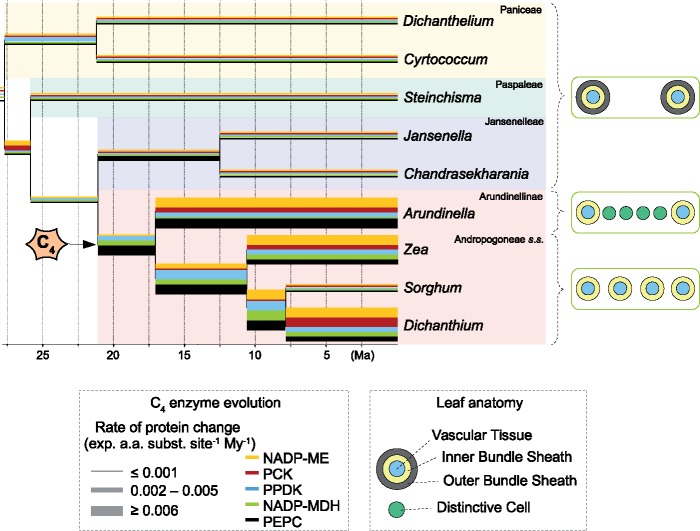
C\documentclass[12pt]{minimal}
\usepackage{amsmath}
\usepackage{wasysym}
\usepackage{amsfonts}
\usepackage{amssymb}
\usepackage{amsbsy}
\usepackage{upgreek}
\usepackage{mathrsfs}
\setlength{\oddsidemargin}{-69pt}
\begin{document}
}{}$_{4}$\end{document}-related changes in protein sequences and leaf anatomy in the Andropogoneae grasses. A time-calibrated phylogenetic tree of Panicoideae is presented, with selected C\documentclass[12pt]{minimal}
\usepackage{amsmath}
\usepackage{wasysym}
\usepackage{amsfonts}
\usepackage{amssymb}
\usepackage{amsbsy}
\usepackage{upgreek}
\usepackage{mathrsfs}
\setlength{\oddsidemargin}{-69pt}
\begin{document}
}{}$_{3}$\end{document} species outside Andropogoneae (see Supplementary Fig. S5 available on Dryad for full phylogenetic tree). Branch thickness is proportional to the rate of protein change and colors represent different C\documentclass[12pt]{minimal}
\usepackage{amsmath}
\usepackage{wasysym}
\usepackage{amsfonts}
\usepackage{amssymb}
\usepackage{amsbsy}
\usepackage{upgreek}
\usepackage{mathrsfs}
\setlength{\oddsidemargin}{-69pt}
\begin{document}
}{}$_{4}$\end{document} enzymes. A simplified transverse section of the leaf is presented on the right, with colors representing the different tissues.